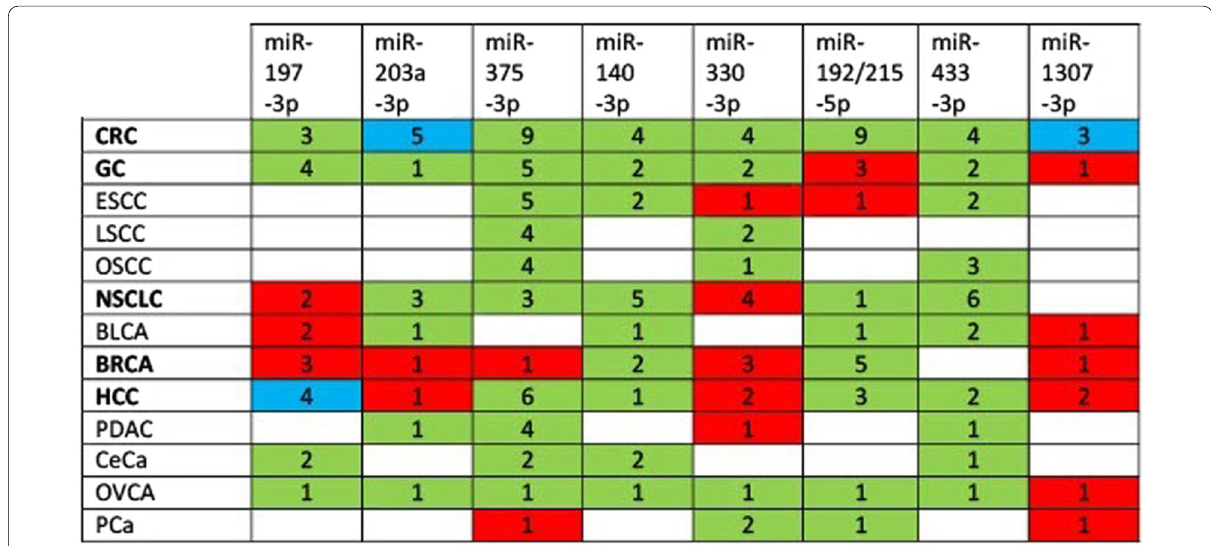
Fig. 2 MiRNA levels in various types of cancer. Downregulated miRNAs in a given cancer type are marked green, upregulated marked red, regulated ambiguously marked blue. Cancer abbreviations as in Table 2. The numbers represent the number of the respective reports referred to in